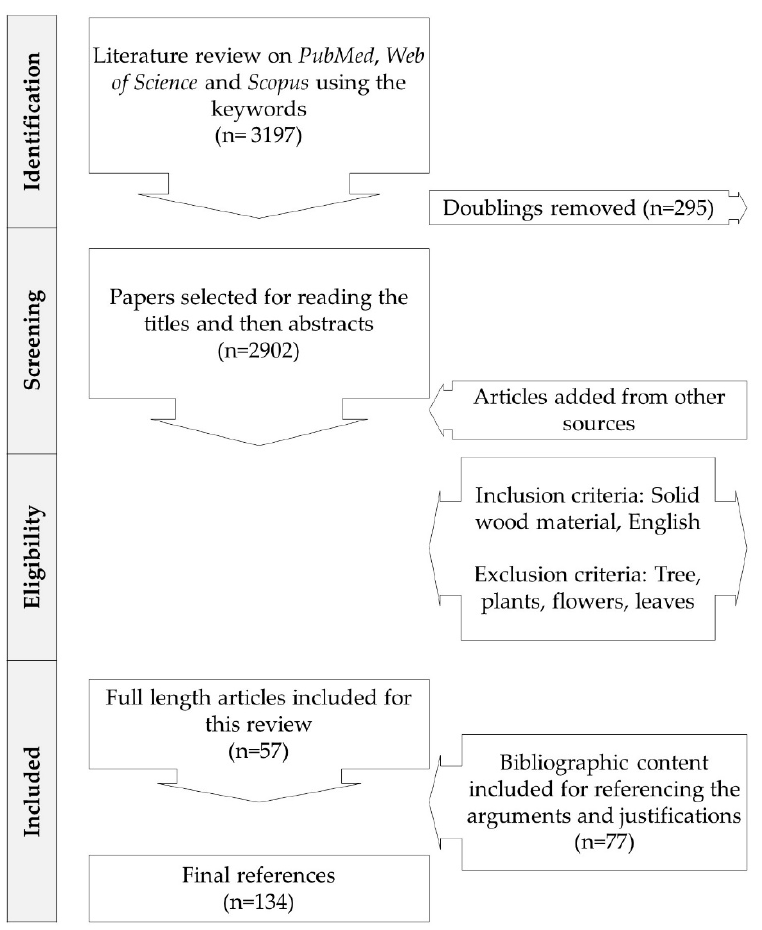
Figure 1. Flow chart of literature review methodology.